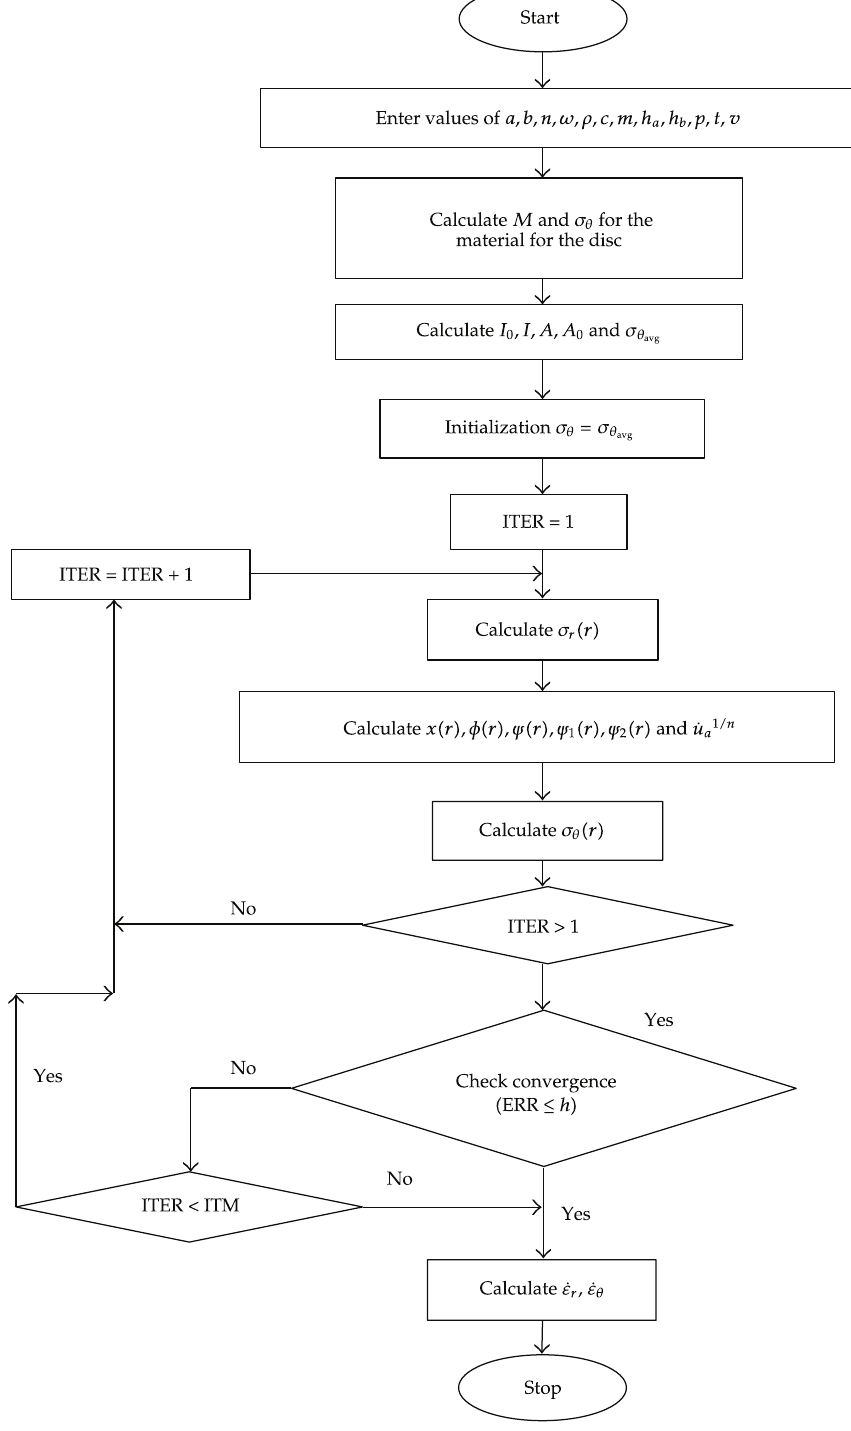
Figure 1: Numerical scheme of